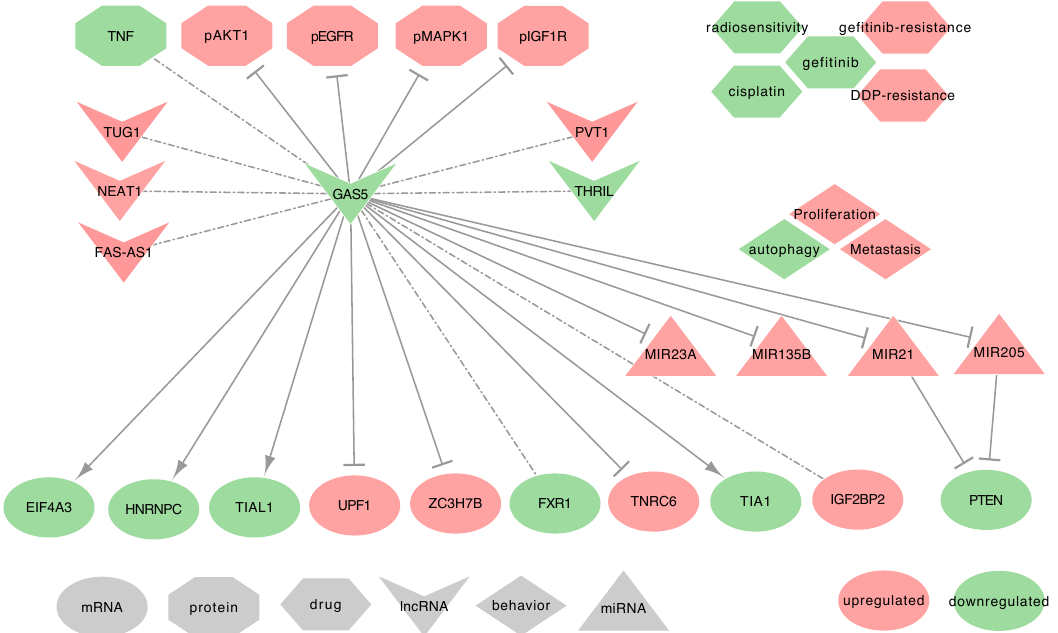
Figure 12. GAS5 in lung cancers: A network of lncRNA-miRNA-Protein interactions. Upregulated molecules are in green. Downregulated molecules are in red. Shape definitions are in grey. Gray arrows target the activated molecules. T-ended lines target the inhibited molecules. Square-ended lines represent a binding between molecules. Dashed-dot lines represent an association with unknown